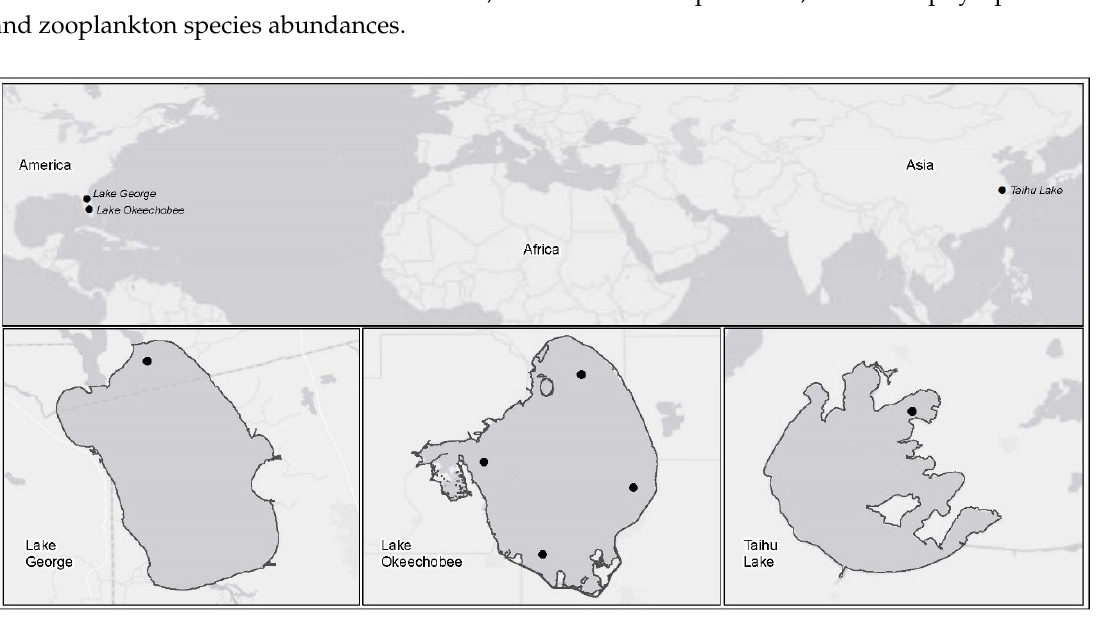
Figure 1. Map of the world showing locations of the three study lakes and inset maps of the lakes and the sampling sites from which data were collected for this study.